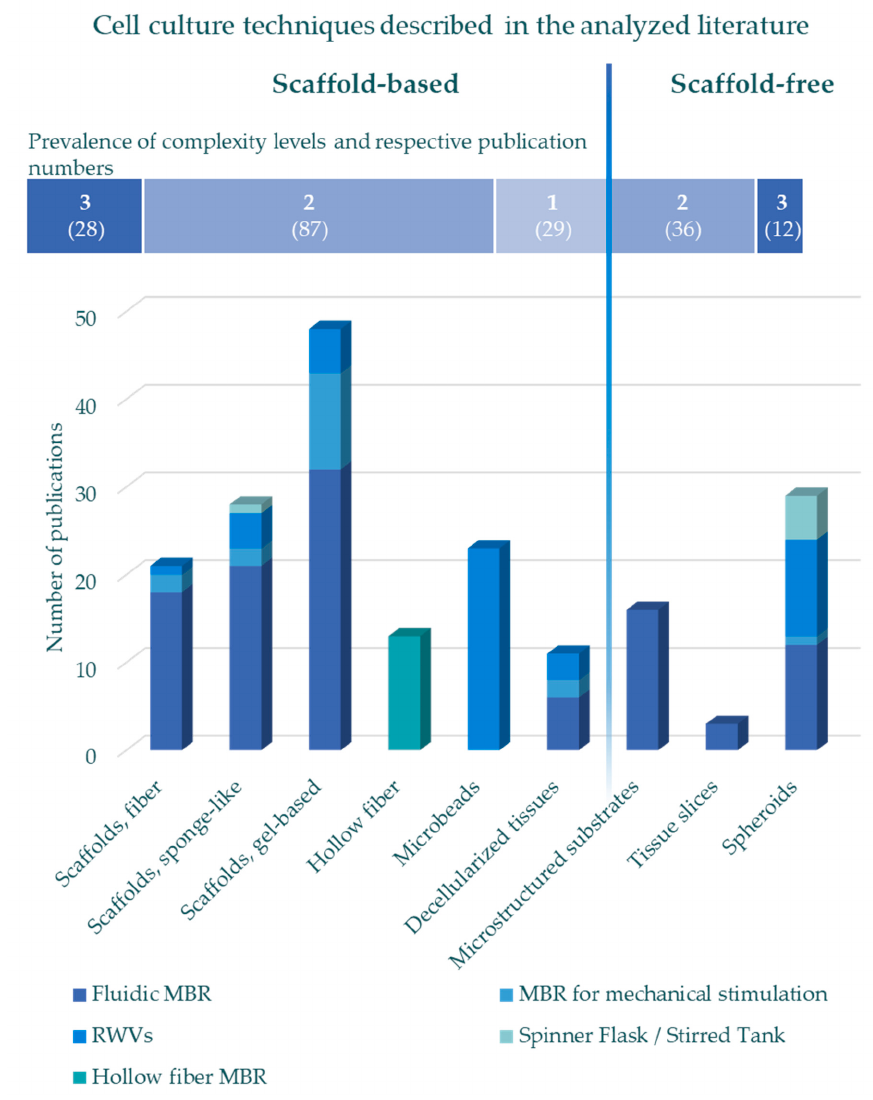
Figure 6. 3D cell culture techniques and their application described in the literature under study. The techniques were organized with regard to their complexity level, the use and nature of the sca ff olds and their application in the various MBR types. The numbers in parentheses refer to the number of corresponding